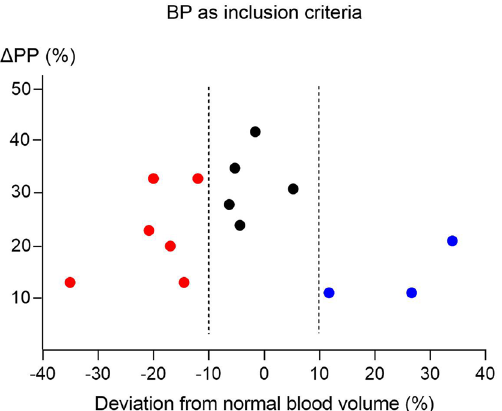
Fig. 4 Change in pulse pressure (ΔPP) following a passive leg raising test in relation to blood volume, in patients included due to systolic BP < 100 or MAP < 65 mmHg. No significant correlation could be found ( r 0.082 (95% CI 0.598–0.483) p 0.78, Spearman correlation coefficient). Dotted lines illustrate limits of = − − = euvolemia